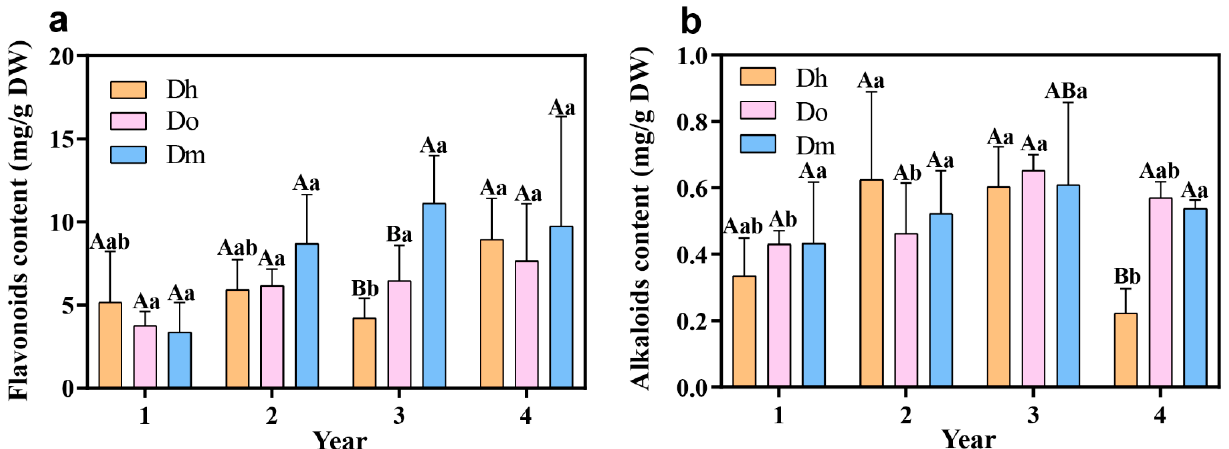
Figure 1. Determination of total flavonoids and alkaloids in stems of three Dendrobium species. ( a ) total flavonoids content in stems of three Dendrobium species of four growth years. ( b ) Total alkaloid content in stems of three Dendrobium species of four growth years. Capital letters indicate differences among different species and lowercase letters indicate differences among different growth years.